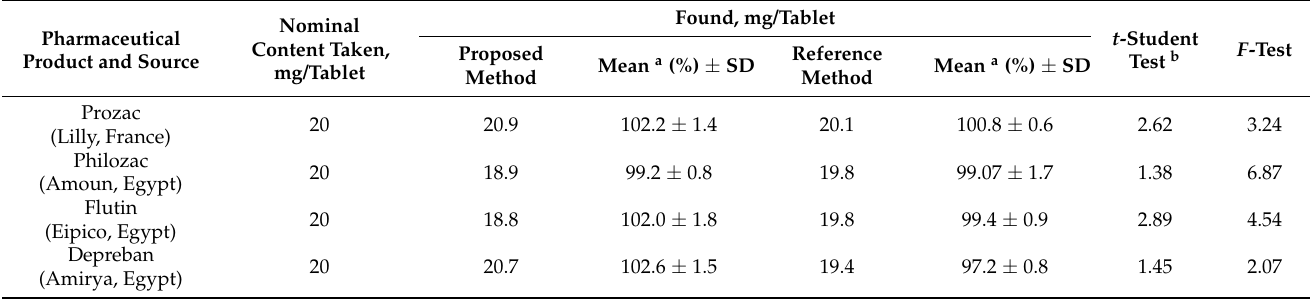
Table 6. Determination of FLX in different pharmaceutical preparations using ionophore (II) membrane-based